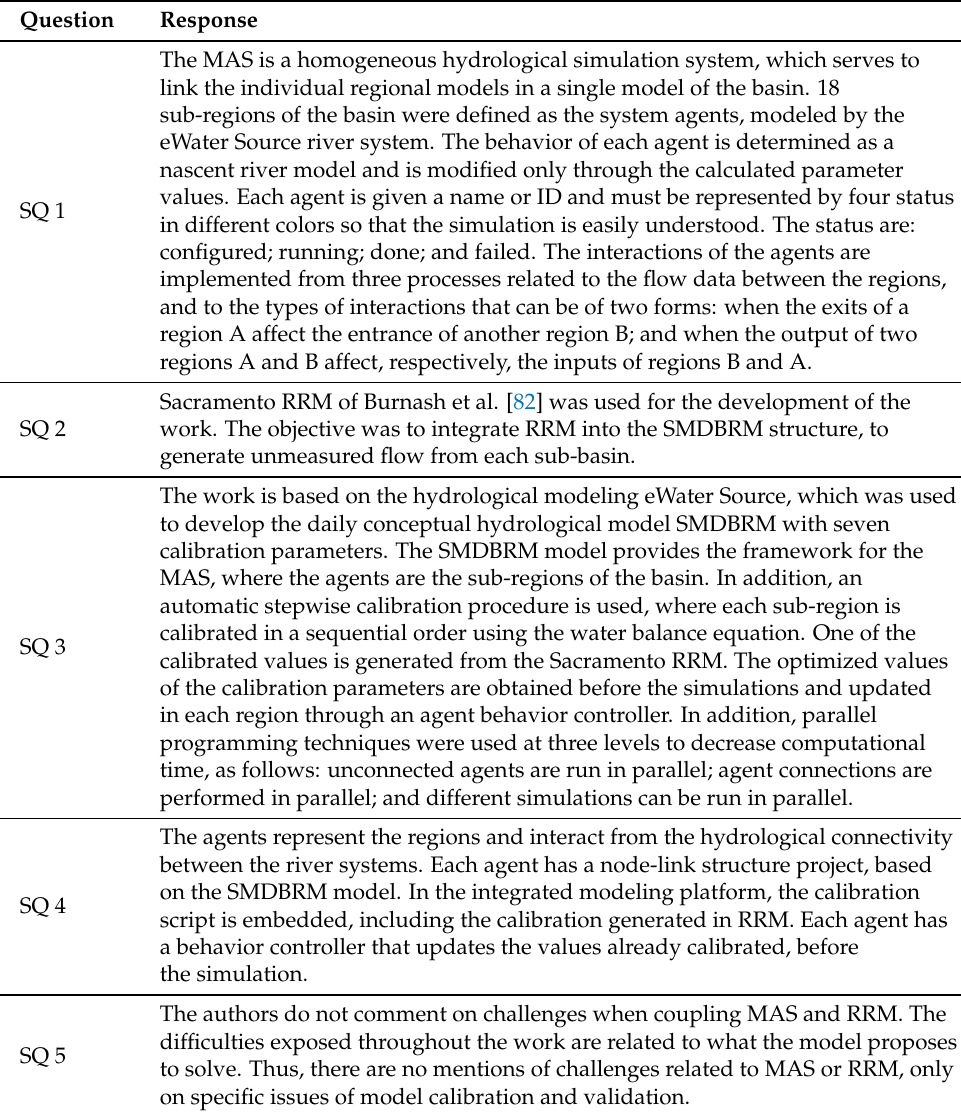
Table A3. Answers of specific questions about the work of Yang et al. [79].